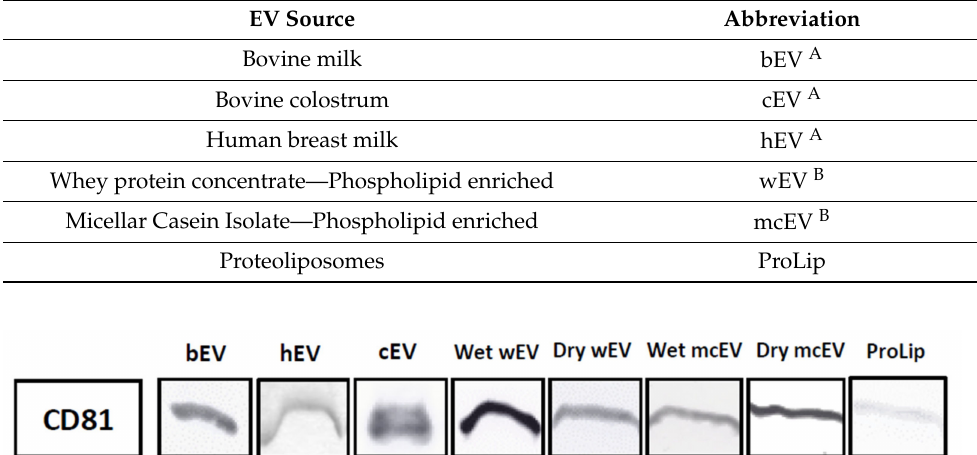
Table 1. Overview of abbreviations for EVs used in this study. A : EV isolation made from raw unprocessed milk. B : two EV isolations were made from fractions before and after drying, referred to as the “wet” or “dry” EV isolate, respectively.